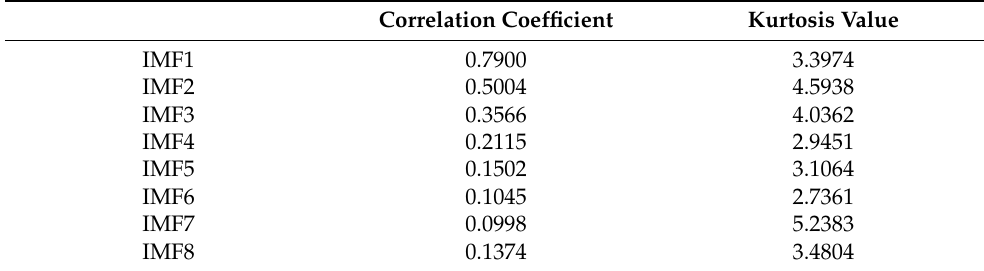
Table 8. Correlation coefficients of IMF components of simulated signals and their kurtosis in- dexes.